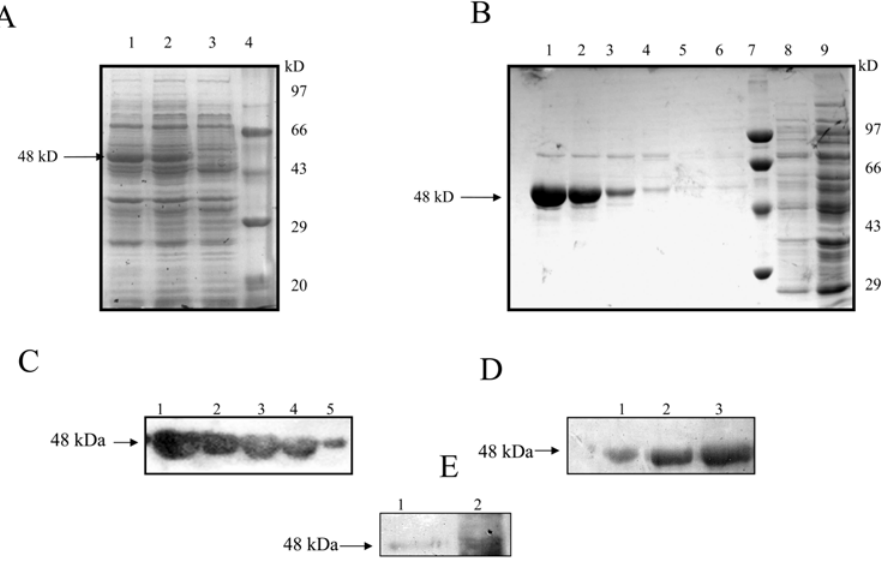
Figure 4. Overexpression and purification of E.histolytica putative ornithine decarboxylase-like protein. (A) Coomassie blue staining of SDS/PAGE showing overexpression of full-length E. histolytica putative ODC-like protein in E. coli. The pET 30a bacterial extract after induction (lanes 1 and 2) at 3 h and 1 h, respectively with 1mM IPTG and before induction (lane 3). The arrow shows the induced recombinant putative ODC-like protein. The broad-range protein MW marker (lane 4) (BioRad) was used to identify the size of recombinant protein. (B) Purification of putative ODC- likeprotein on Ni 2 + affinity resin. Lanes 1–4, eluted fractions showing purified putative ODC-like protein from affinity column; lanes 5, 6, and 8 are washes; lane 7, broad-range protein MW marker (BioRad); lane 9, supernatant from the crude lysate. (C) Western blot using anti-His antibody. Western blot analysis of different concentrations of purified putative ODC-His fusion recombinant protein. Lanes 1–5 represent 25, 20, 18, 15, and 5 m g of recombinant proteins, respectively. (D) Western blot using anti- E. histolytica ODC. Lanes 1–3 represent 2, 3, and 6 m g of purified recombinant protein. Prestained broad-range protein molecular weight marker (BioRad) was used to identify the size of the protein on the Western blot. (E) Western blot using anti- E. histolytica ODC. Lane 1, purified recombinant protein. Lane 2, E. histolytica lysate. Prestained broad range protein molecular weight marker (BioRad) was used to identify the size of the protein on the Western blot.